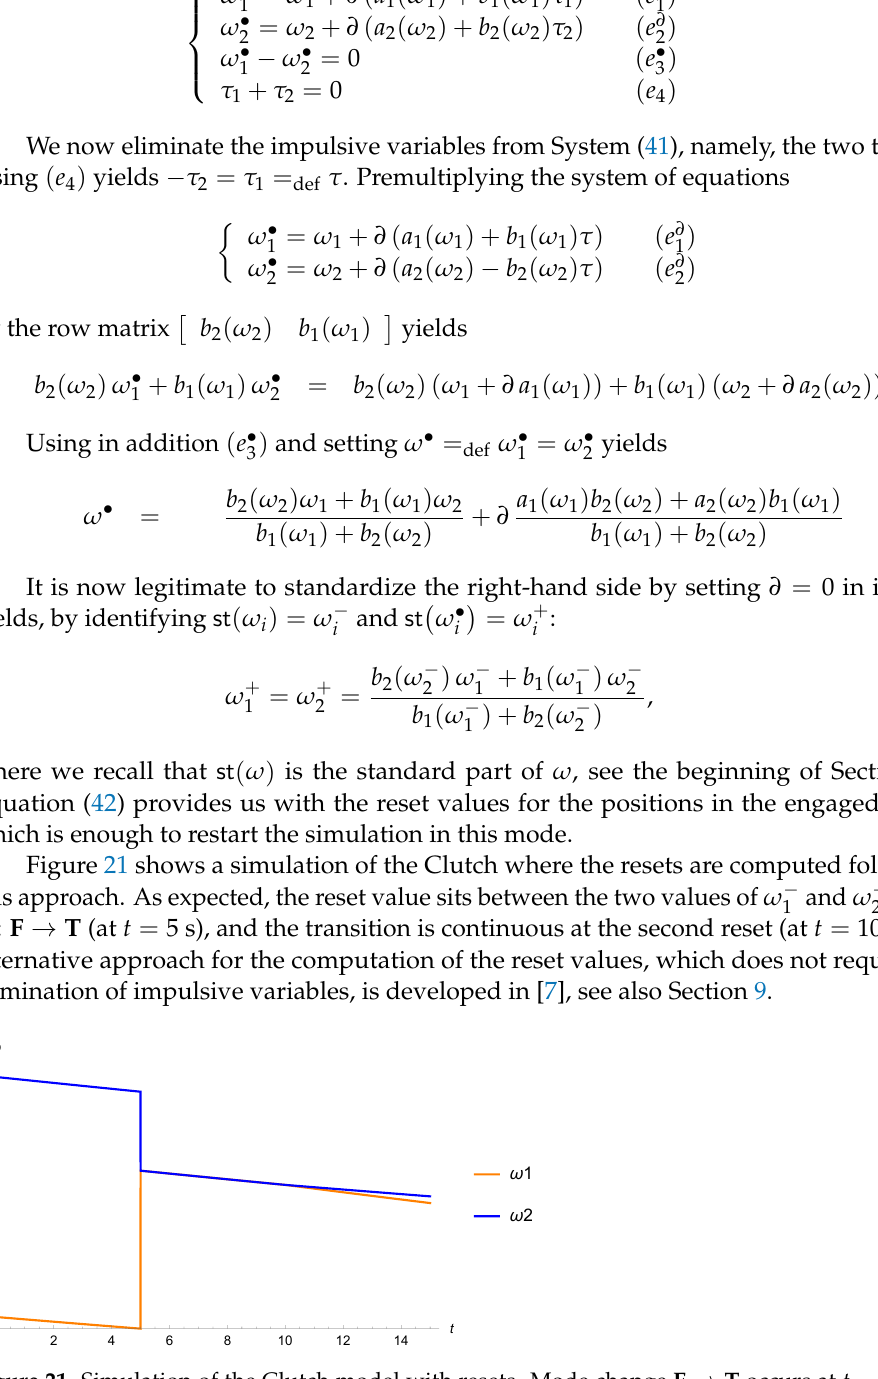
T occurs at t = 5 s and →